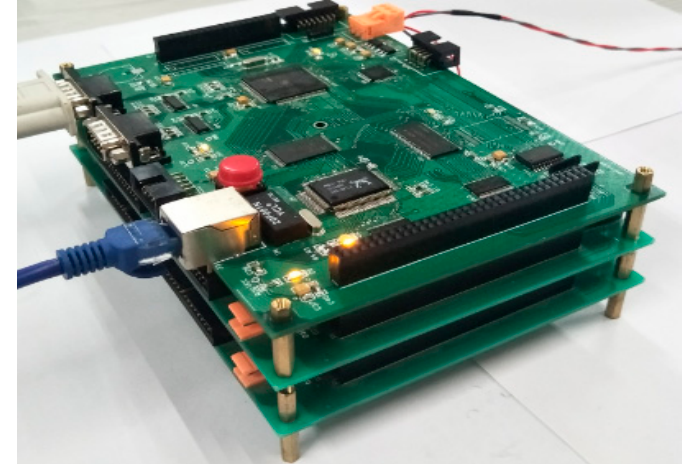
Figure 4. Overall design of the hardware system.